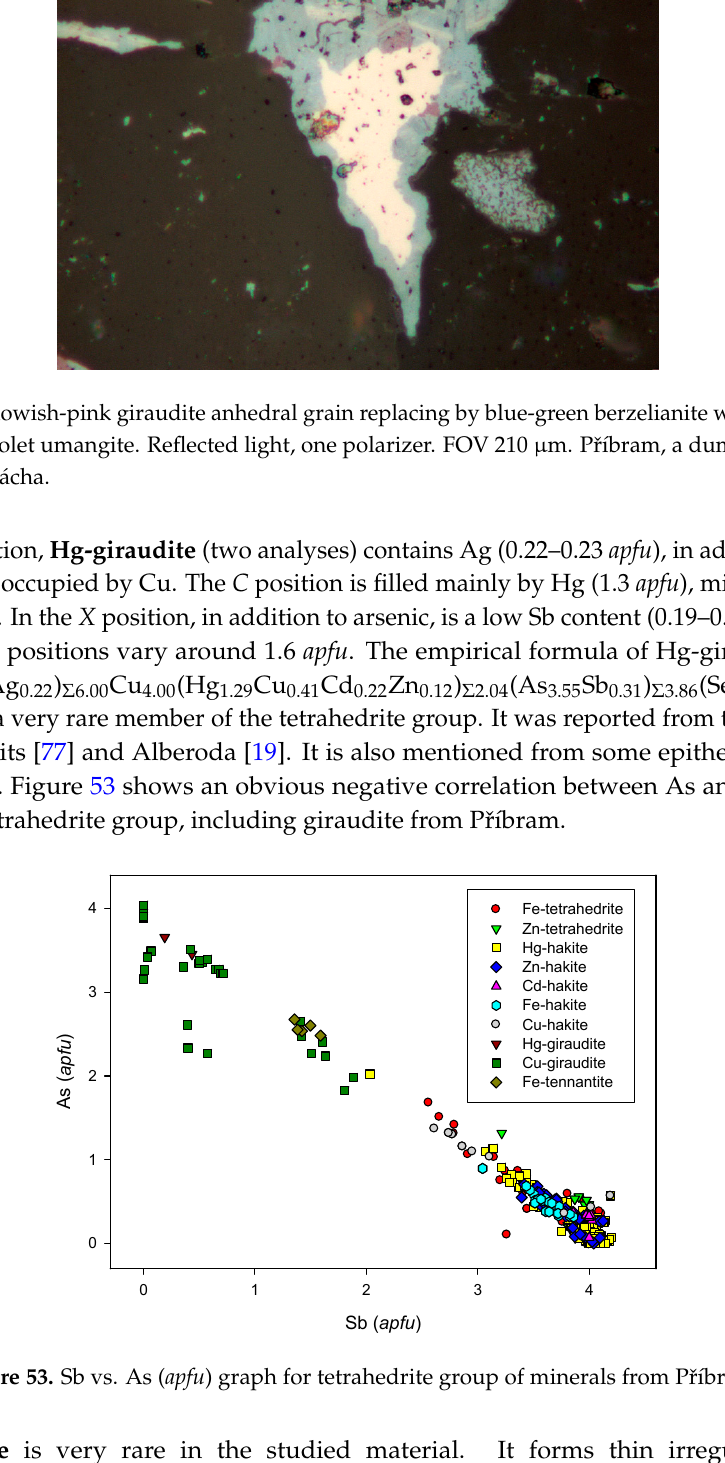
Figure 51. The core of aggregate formed by hakite (light grey) is rimmed by giraudite (grey); berzelianite (dark grey) is the youngest mineral in the association. BSE photo. P ř íbram, a dump of shaft 16. Photo by J. Sejkora and P. Škácha.